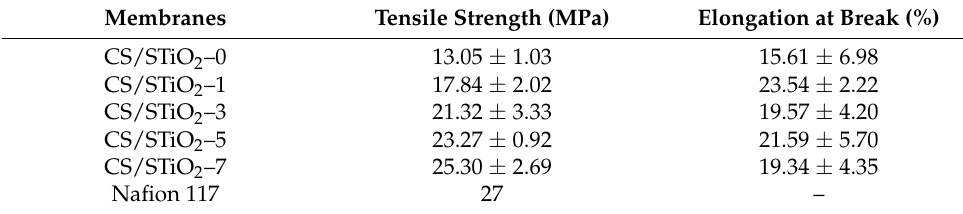
Table 3. Mechanical properties of CS control and CS/STiO 2 nanocomposite membranes .